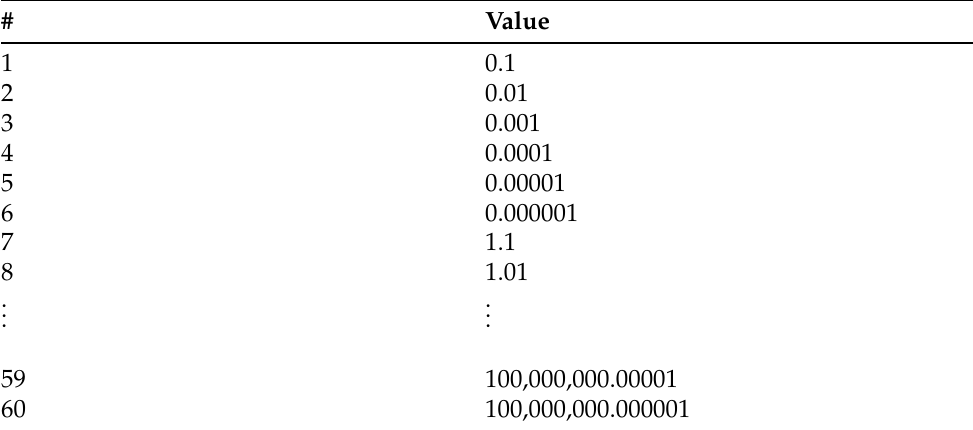
Table 7. Used values for scaling and translation